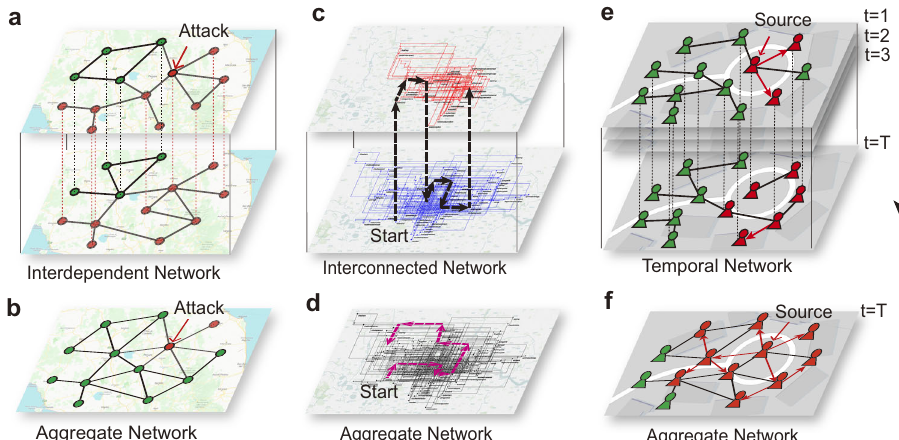
Fig. 1 The different consequences for dynamics occurring on a multiplex network and the corresponding aggregate monoplex network. a Once a node fails due to attack, the cascade of failures will result in a catastrophic removal of nodes (red nodes in the network) in an interdependent multiplex network. b Attacking the same node in the aggregate network will not trigger such a catastrophic outcome (only another one node disconnects from the giant connected component). c A random walk process in a multiplex transportation network, where the black dashed line indicates a possible path of the random walk process and the arrows indicate the direction of the random walk. d A random walk process in the corresponding aggregate network, where the red dashed line indicates a possible path of the random walk process. e In a temporal contact network, the topology changes in time and, as a consequence, an infection (red individuals) spreads slowly in time, leading to a lower number of infected individuals at time t = T with respect to f the same epidemics spreading on the aggregated network. The geographic data are provided by